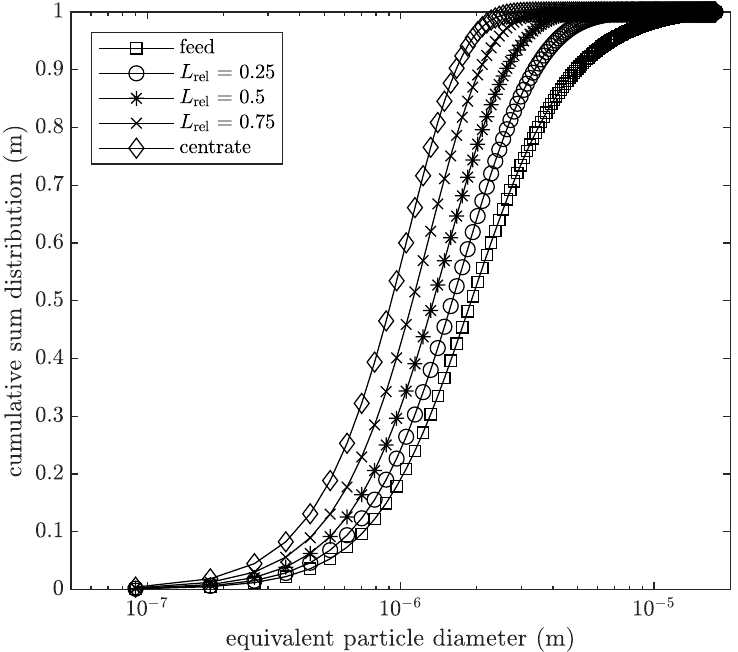
Figure 12. Particle size distribution along unrolled helix for industrial-scale decanter centrifuge with CC1 at a rotational speed of 2950rpm and a feed rate of 3000 Lh − 1